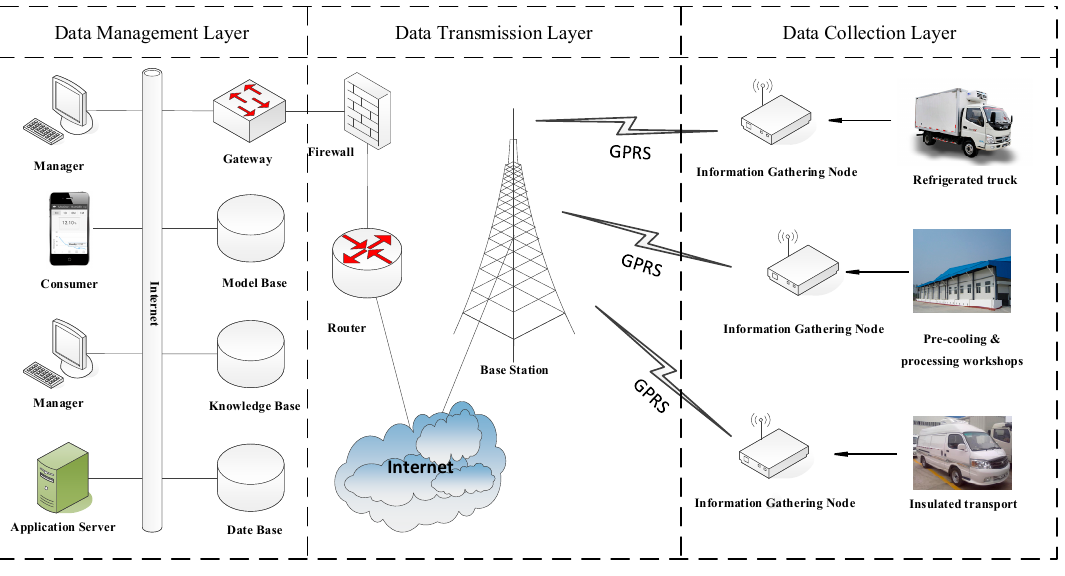
Figure 2. System architecture of RM-TM.